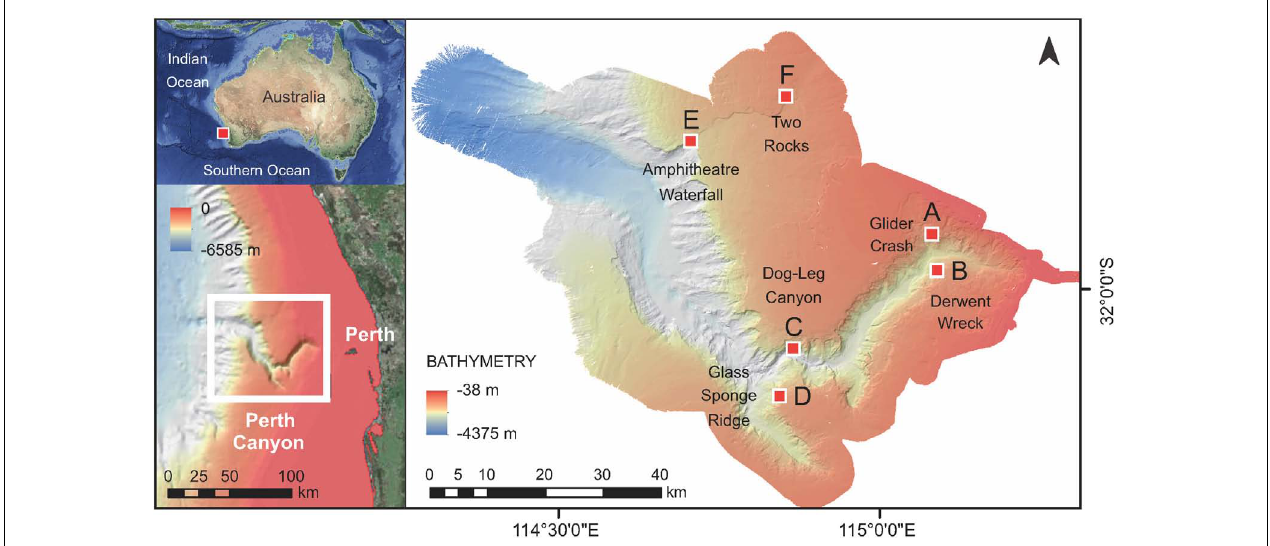
FIGURE 1 | Satellite images of the location of the Perth Canyon and bathymetry map. Bathymetry map (right) prepared from multi-beam sonar data taken during the RV Falkor cruise. Location of the six ROV dive surveys (Sites A–F) are indicated. Note the lack of connectivity of the canyon to the coast (bottom left).